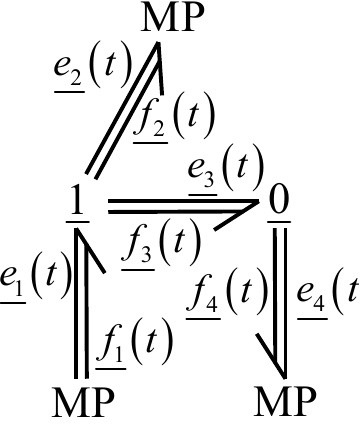
Fig. 1 . Power bond. Fig. 2 . Causal bond.